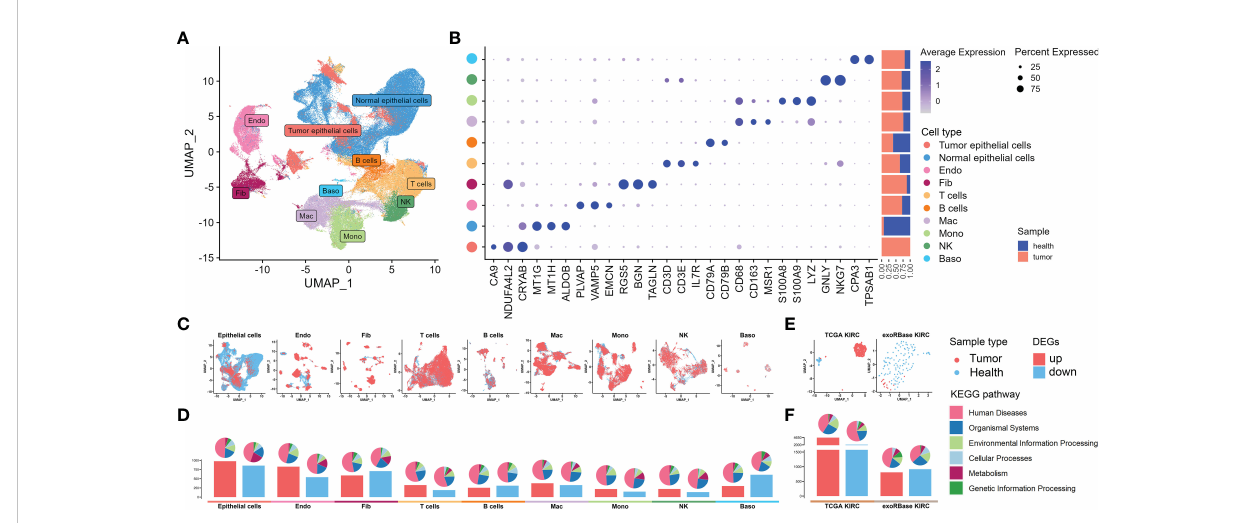
FIGURE 2 Single-cell RNA sequencing (scRNA-seq) and bulk RNA sequencing (RNA-seq) pro fi ling of kidney renal clear cell carcinoma (KIRC). (A) Uniform manifold approximation and projection showing the 10 major cell clusters in the scRNA-seq datasets. (B) Marker genes and proportions of sample origins for the 10 major cell clusters of the scRNA-seq datasets. (C) Distribution characteristics of the 10 major cell clusters in the scRNA-seq datasets. (D) Barplots showing the counts of differentially expressed genes (DEGs) between the cancer and control samples of each cell cluster in the scRNA-seq datasets. (E) Distribution characteristics of The Cancer Genome Atlas (TCGA) KIRC cohort merged with control cases from the GTEx database (left) and exoRBase KIRC cohort (right) containing the RNA-seq data of blood-derived exosomes of patients. (F) Barplots showing the counts of DEGs between the KIRC and healthy cases of TCGA KIRC and exoRBase KIRC cohorts. The pie plots at the top of the bar show the Kyoto Encyclopedia of Genes and Genomes pathway enriched by each group of